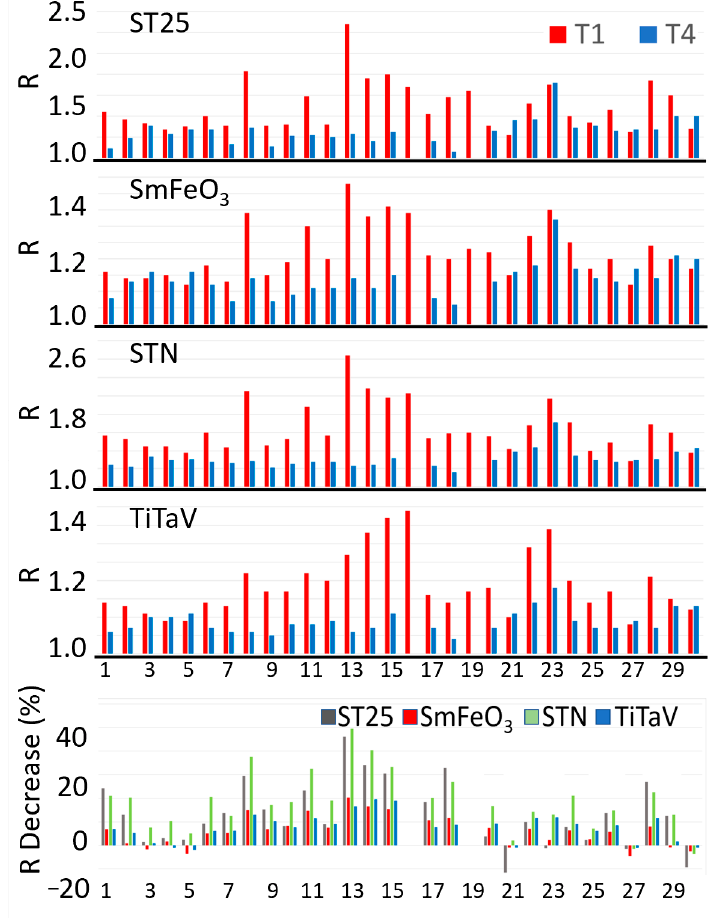
Figure 4. After ‐ surgery follow ‐ up of 28 patients. The four upper panels show the R amplitudes for each sensor at T1 and T4 times for each patient. The bottom panel shows the R percentage reductions in T4 in respect to T1 for each sensor and patient. The numbers in abscissa in all panels represent the randomized patient numbers; the patients n. 16 and n. 19 of the bottom panel are absent because they provided the T1 sample only (see text). they provided the T1 sample only (see